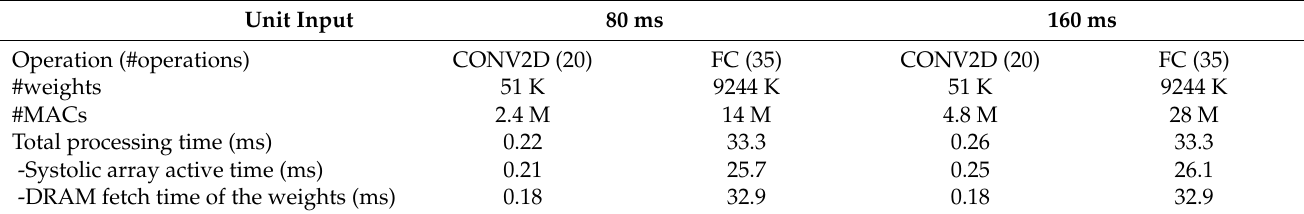
Table 11. Measured performance of CONV2D and FC operations in proposed hardware AM.